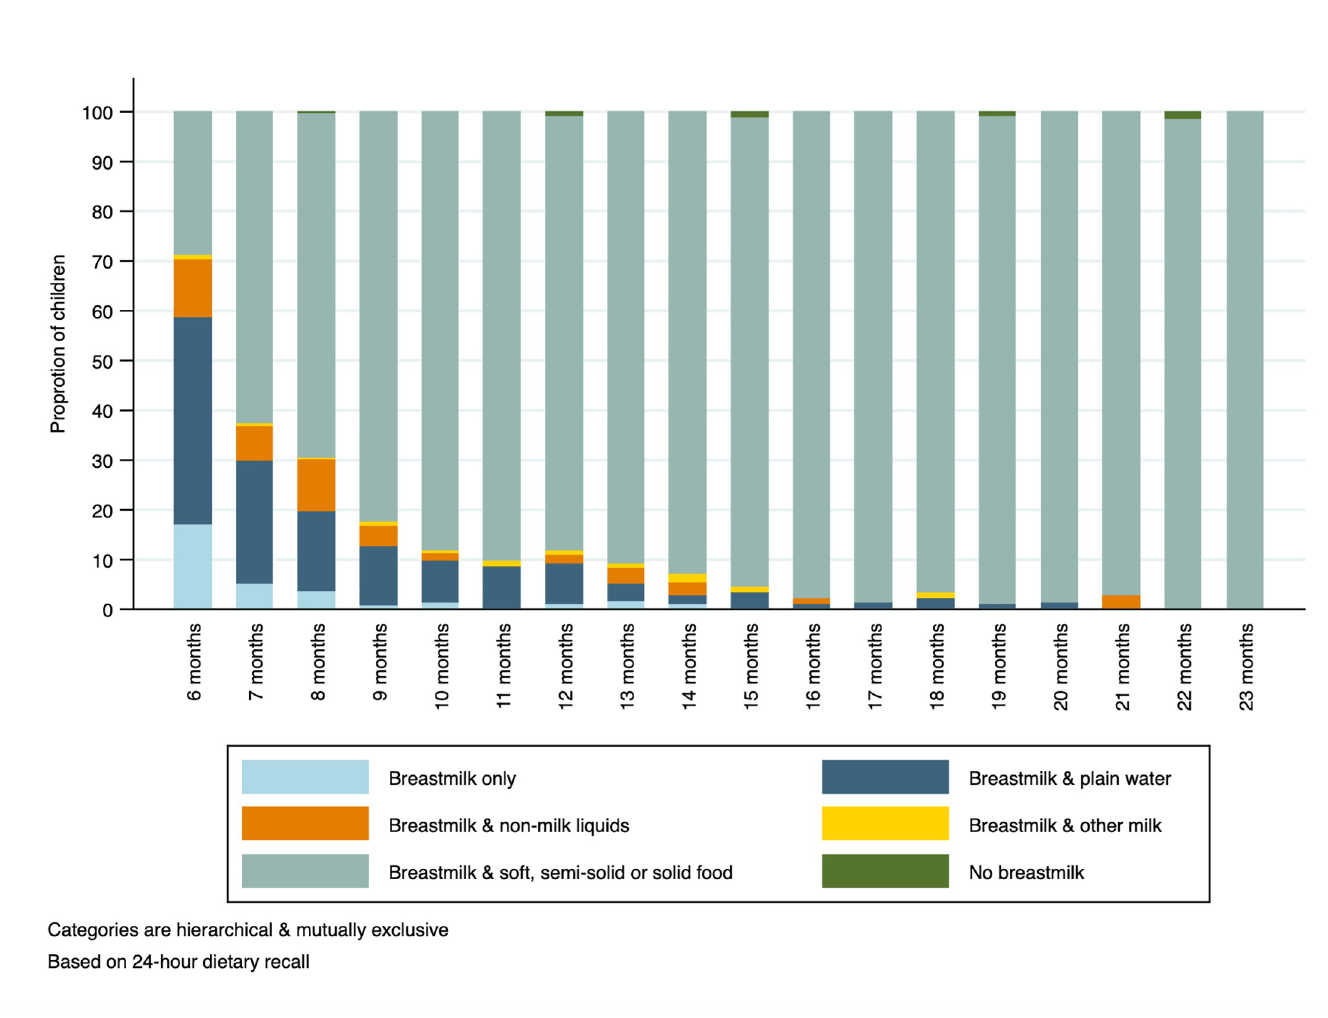
Fig 1. Child feeding patterns by age during the day and night prior to interview (N =